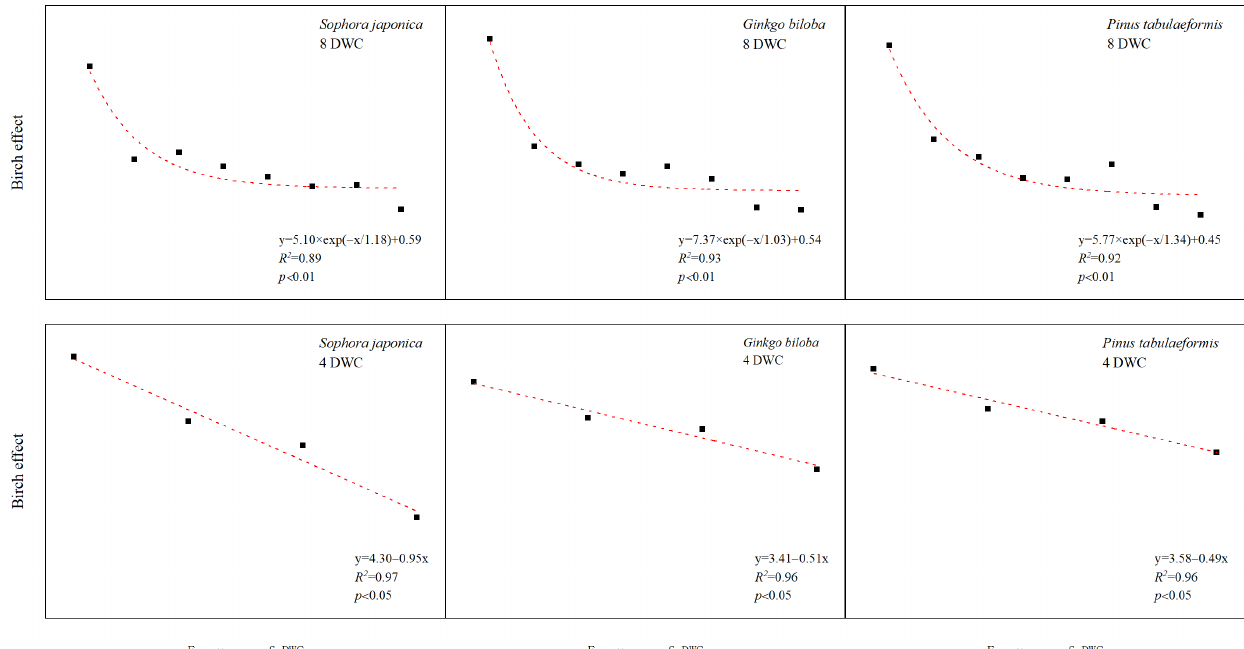
Figure 4. Effects of different drying and rewetting cycle frequencies on the Birch effect of soil CO 2 . The initial and final Birch effect values of soil under S. japonica with eight DWCs were 2.87 and 0.19, respectively, which was a decrease of 93.5%, and those with four DWCs were 3.40 and 0.39, respectively, which was a decrease of 88.6%. The Birch effect of the soil under G. biloba decreased from 3.39 (first cycle) to 0.18 (last cycle) with eight DWCs, and the percentage decrease was 94.6%. The Birch effect value with four DWCs decreased from 2.93 (first rewetting cycle) to 1.30 (last rewetting cycle), and the percentage decrease was 55.8%. The initial and final Birch effect values of the soil under P. tabulaeformis with eight DWCs were 3.26 and 0.09, respectively, which was a decrease of 97.4%. The Birch effect value with four DWCs decreased from 3.17 to 1.61 (49.3% decrease).